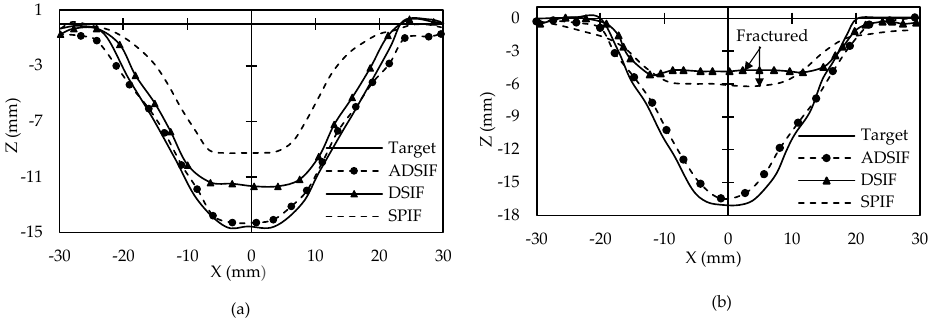
Figure 16. Comparison of ideal and formed geometries formed using the ADSIF, out-to-in DSIF toolpath and with SPIF for ( a ) 40 ° cone and ( b ) 50 ° cone (reprinted with permission from Malhotra et al. [31], Copyright 2012 Elsevier).